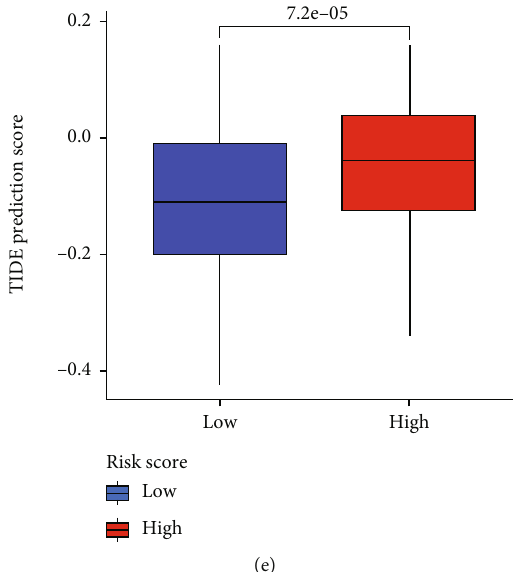
Figure 10: Clinical signi fi cance of the risk model in immune landscape. Boxplot was used to visualize the di ff erence of HLA and immune check points between the high-risk group and the low-risk group ((a) and (b)). Enrichment of 13 immune-related pathway was evaluated by using ssGSEA (c). Patients in low-risk group with positive status of CTLA4 or PD-1 have superior immunotherapy scores than high-risk group (d). TIDE prediction score indicated that low-risk patients might be more sensitive to immunotherapy